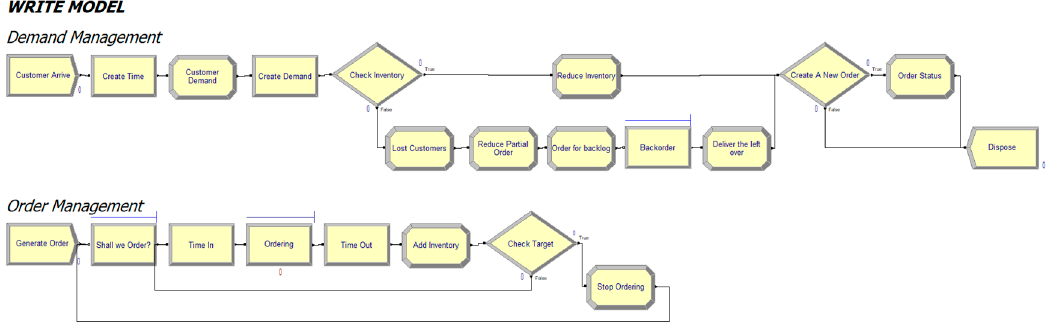
Figure 5. Write model of inventory review policy.